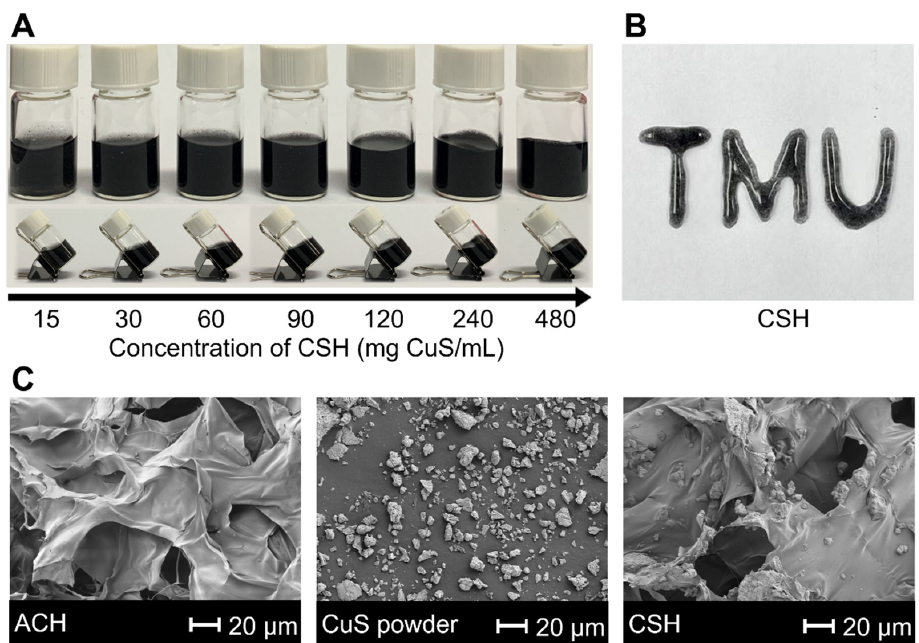
Figure 2. ( A ) Standing and oblique photos of different concentrations of CSH taken immediately after the preparation. ( B ) “TMU” formed by CSH (20 mg CuS/mL) through a 0.45 mm syringe needle. ( C ) SEM images of ACH, CuS particles, and CSH (20 mg CuS/mL).